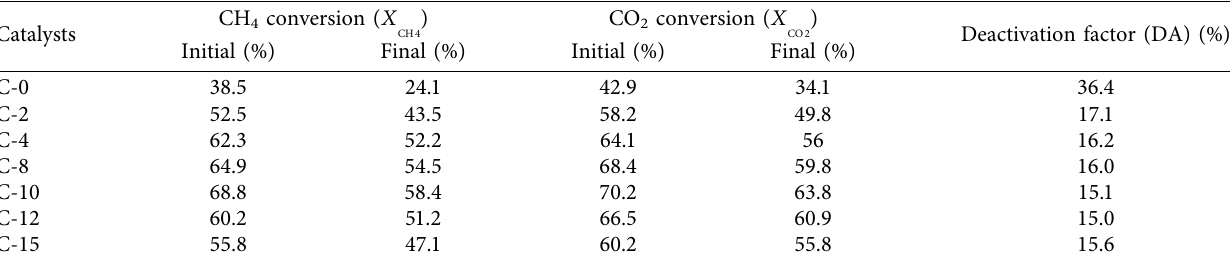
Table 2: Conversion and deactivation factors for synthesized catalysts.